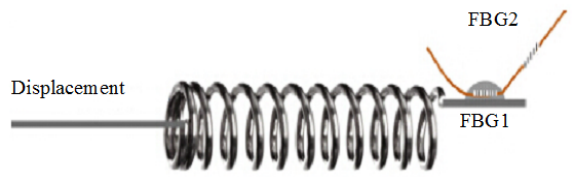
Fig. 5 Schematic of the sensing head of the long-range displacement sensor.